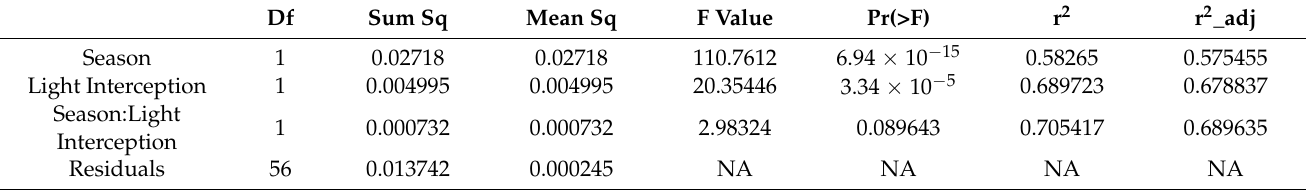
Table A17. Dry matter content.